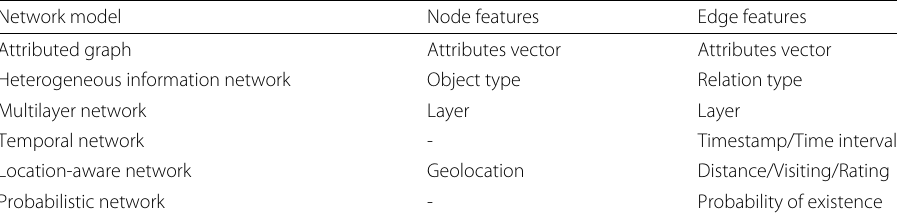
Table 1 Table summarizing the main features exposed for nodes and edges for the discussed feature-rich network